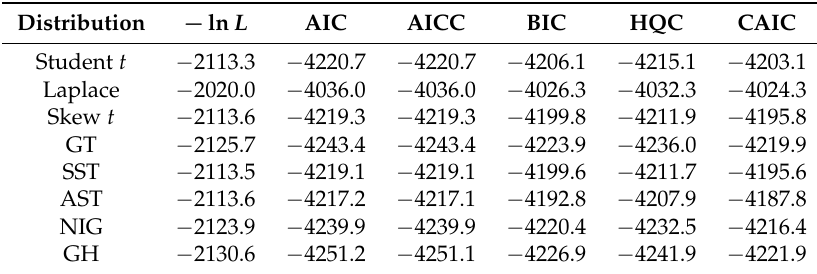
Table 7. Fitted distributions and results for daily log returns of the exchange rates of Litecoin